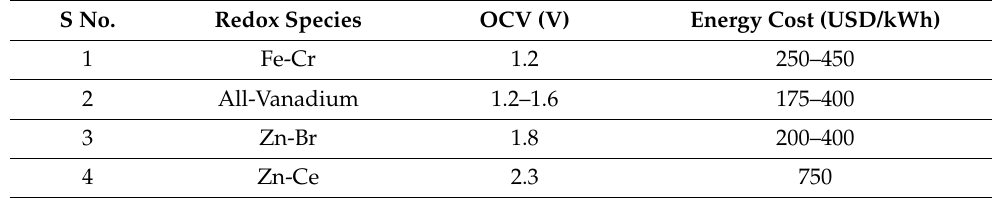
Table 1. Comparison of estimated energy storage cost of redox flow battery systems [9]. S No. Redox Species OCV